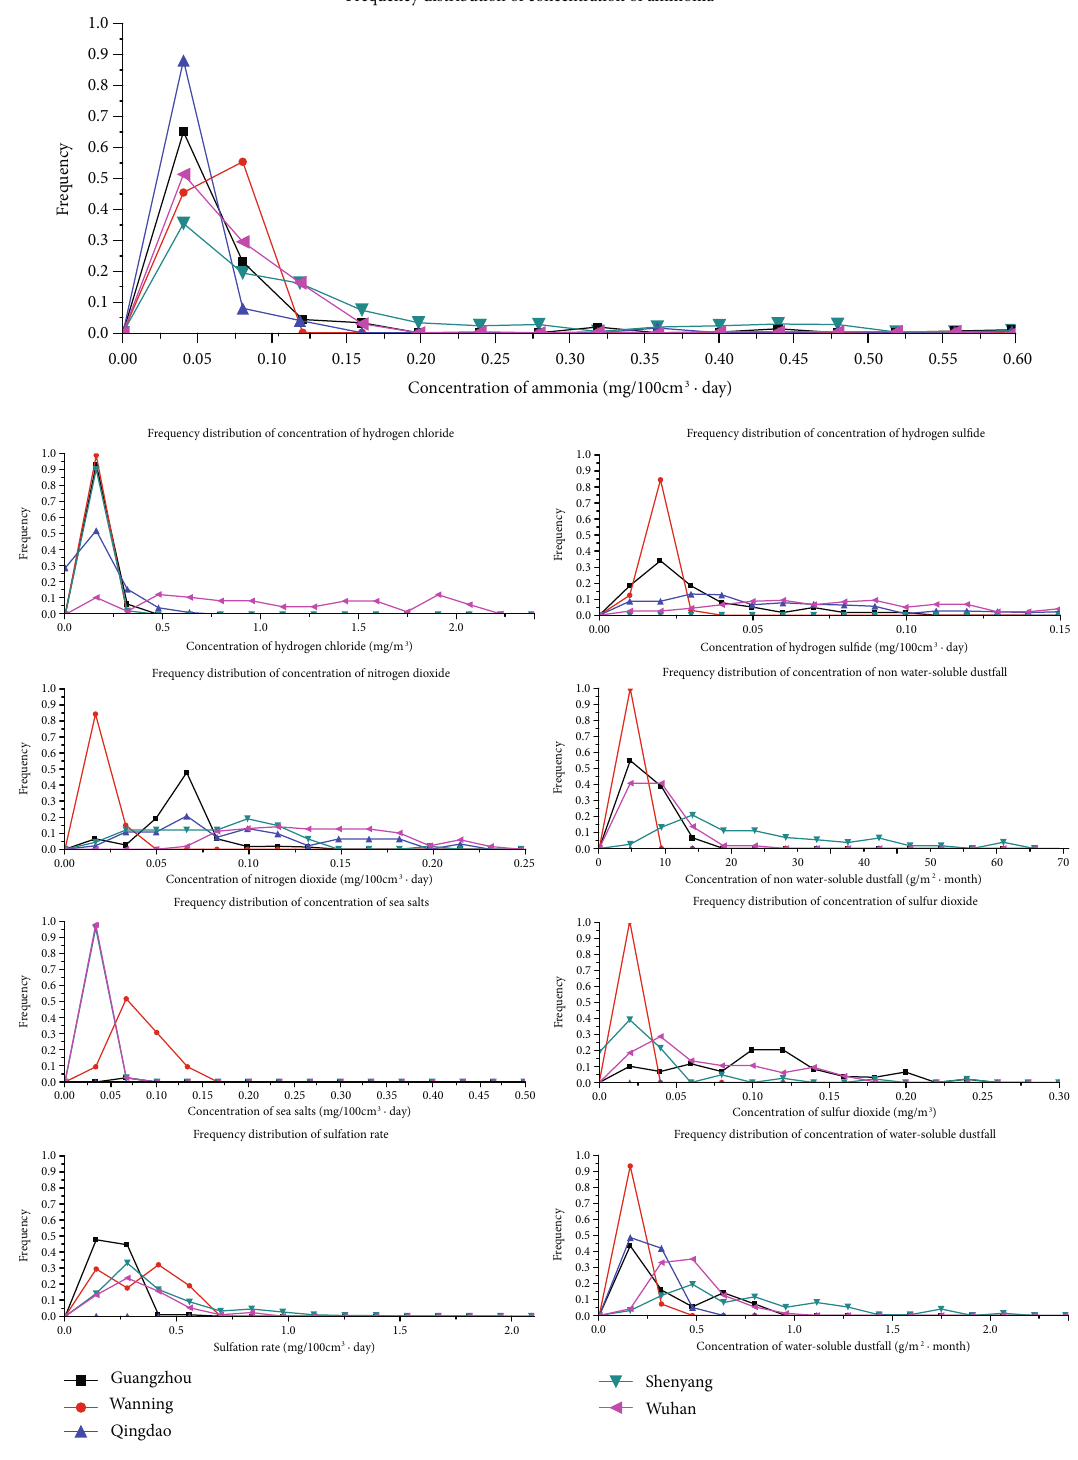
Figure 4: Frequency distribution graphs of pollutant